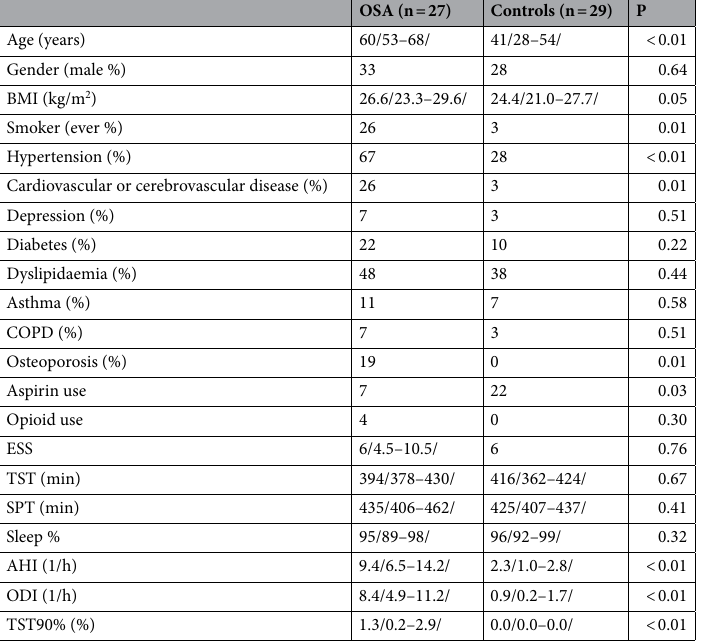
Table 1. Comparison of demographics and clinical characteristics of patients with OSA and controls. AHI apnoea-hypopnoea index, BMI body mass index, COPD chronic obstructive pulmonary disease, ESS Epworth Sleepiness Scale, ODI oxygen desaturation index, OSA obstructive sleep apnoea, Sleep%—sleep efficiency, SPT sleep period time, TST total sleep time, TST90% percentage of total sleep time spent with oxygen saturation below 90%. Data are presented as median /interquartile